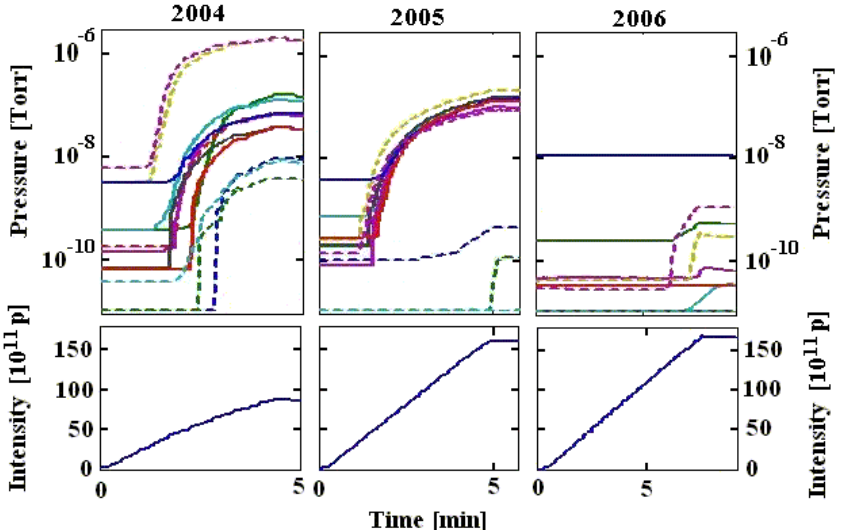
FIG. 17. (Color) Dynamic pressure in the 12 Blue warm straight sections (top), measured by a single gauge in each, while proton beam with 108 ns bunch spacing is filled (bottom). Data was obtained in 2004–2006. The beam conditions were chosen for comparison of dynamic pressure rise, not for typical operations. With completely NEG coated pipes, the pressure in 3 sections in 2005, and 5 sections in 2006, remained at 10 (cid:6) 11 Torr [63].